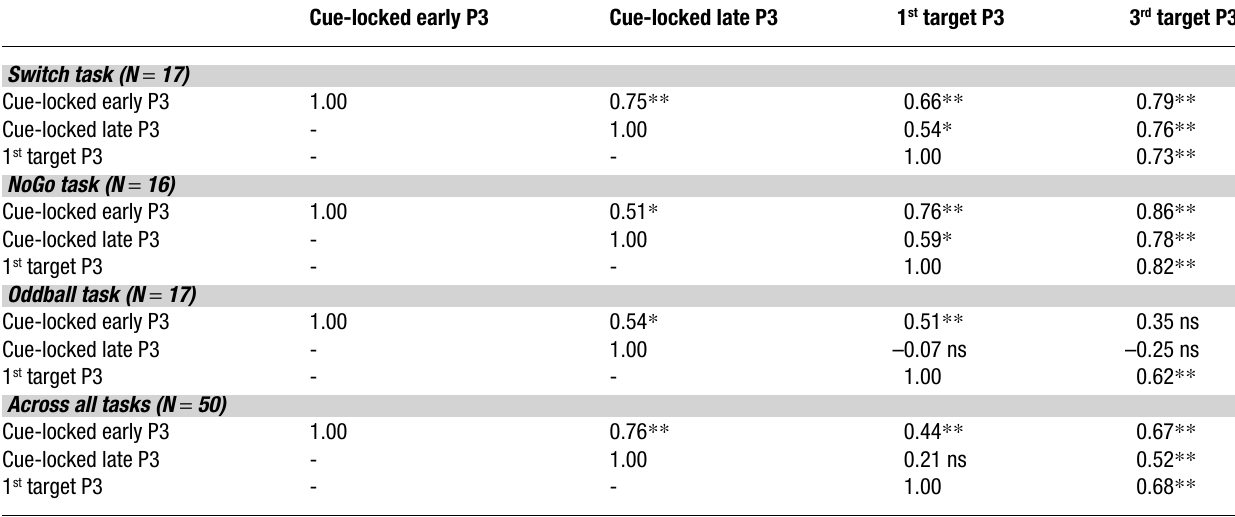
Table 4. Pearson product-moment correlations between mean P300 amplitudes measured at Cz.